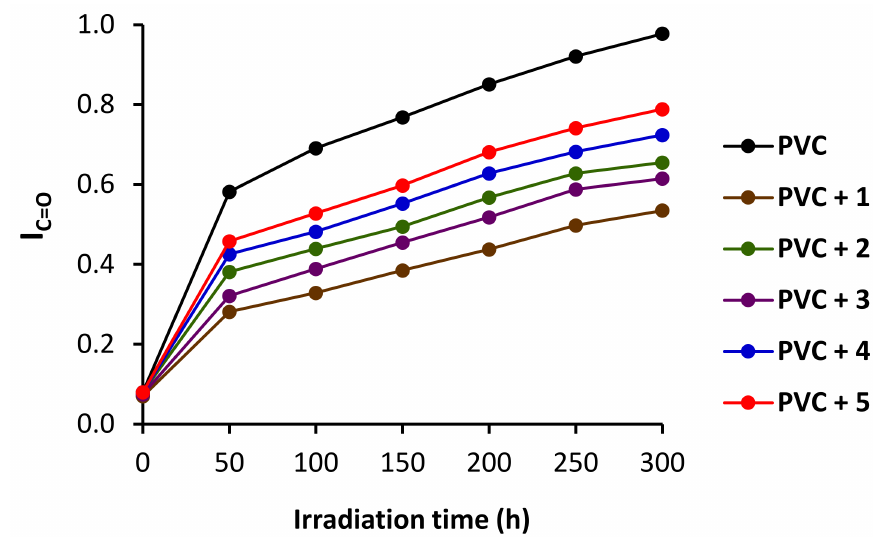
Figure 6. The I C=O index against irradiation time for PVC films.